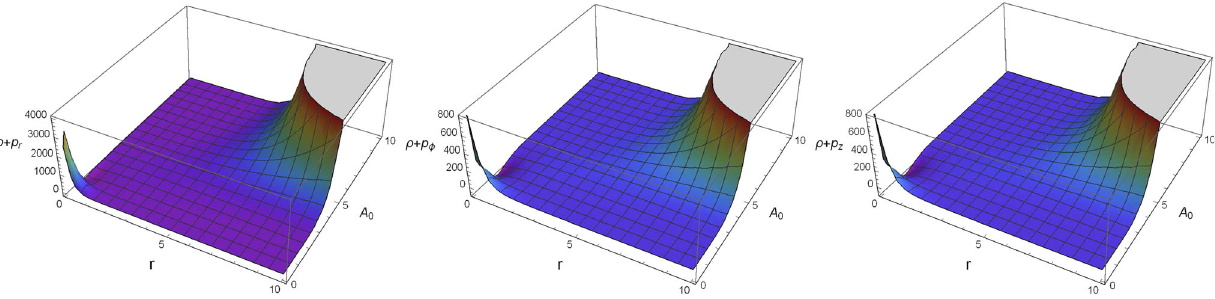
Fig. 18 Here, we shows the variation of (ρ + p r ) (MeV/fm 3 ) , (ρ + p φ ) (MeV/fm 3 ) and (ρ + p z ) (MeV/fm 3 ) w.r.t r (km) with m = n = 1. CASE